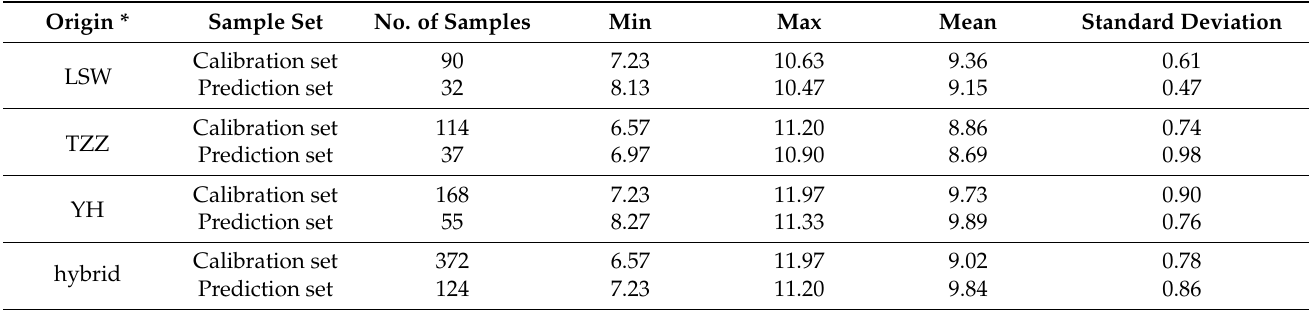
Table 3. Measured values of soluble solids content (SSC/%) in ‘Dangshan’ pear in the calibration and prediction data sets of four different origins.